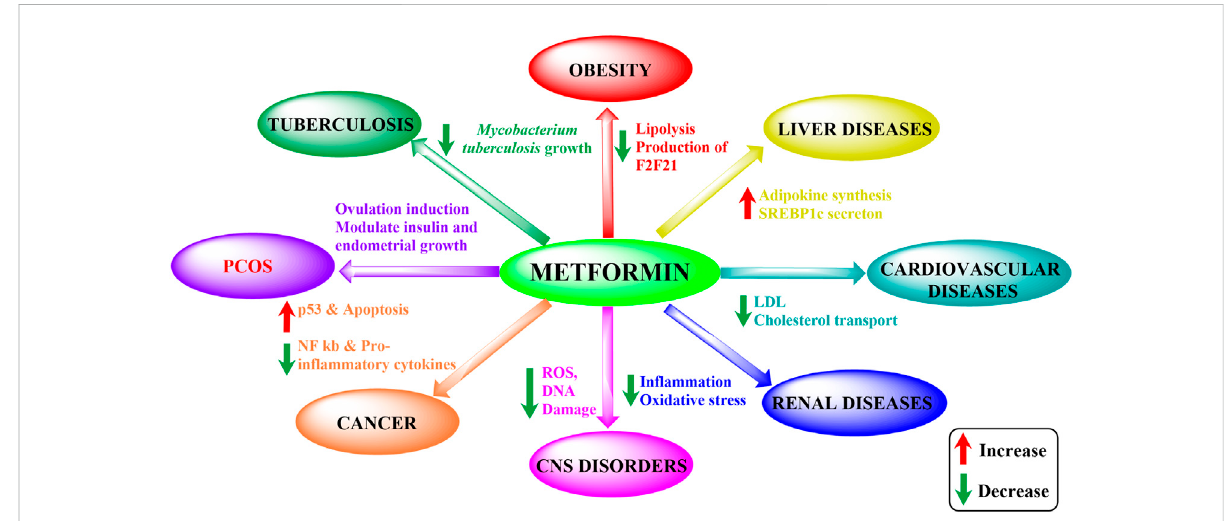
FIGURE 1 Metformin ’ simpactondifferentdisorders.ROS,reactiveoxidativespecies;PCOS,polycysticovarysyndrome;LDL,low-densitylipoprotein;NF- κ B, nuclear factor kappa-light-chain-enhancer of activated B cells; SREBP1c, sterol regulatory element-binding protein